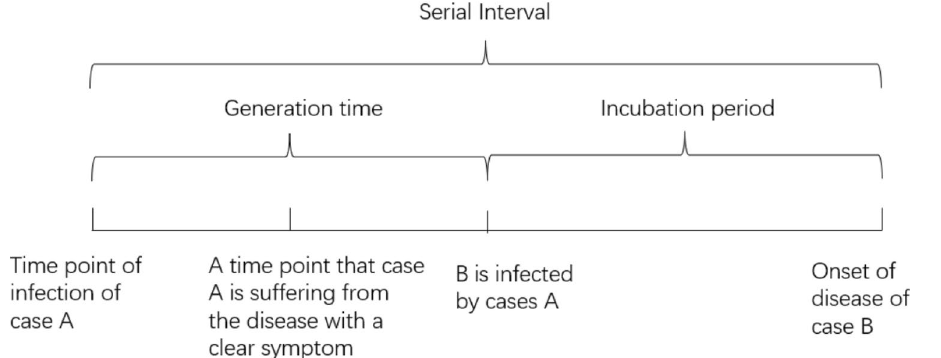
Figure 3. The time interval between the onset of symptoms in different generations (serial